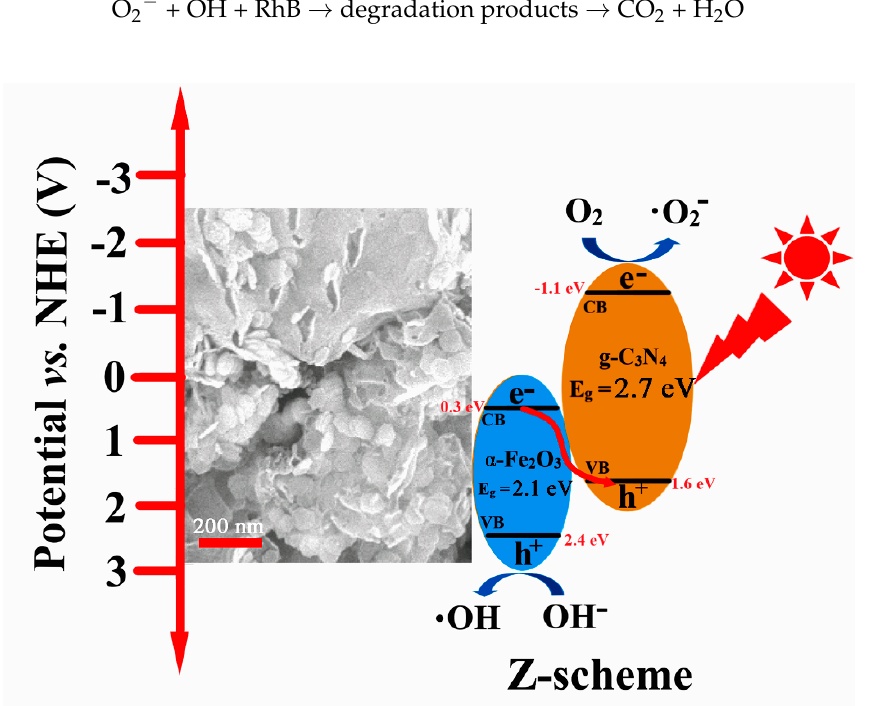
Figure 6. Schematic illustration of the charge carrier separation and transfer on α -Fe 2 O 3 @g-C 3 N 4 photocatalyst.